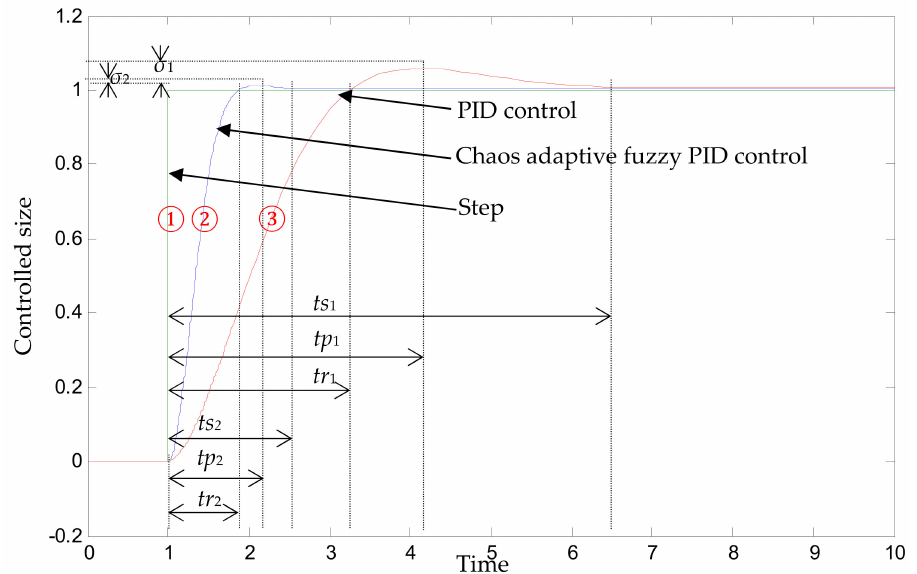
Figure 7. Simulation